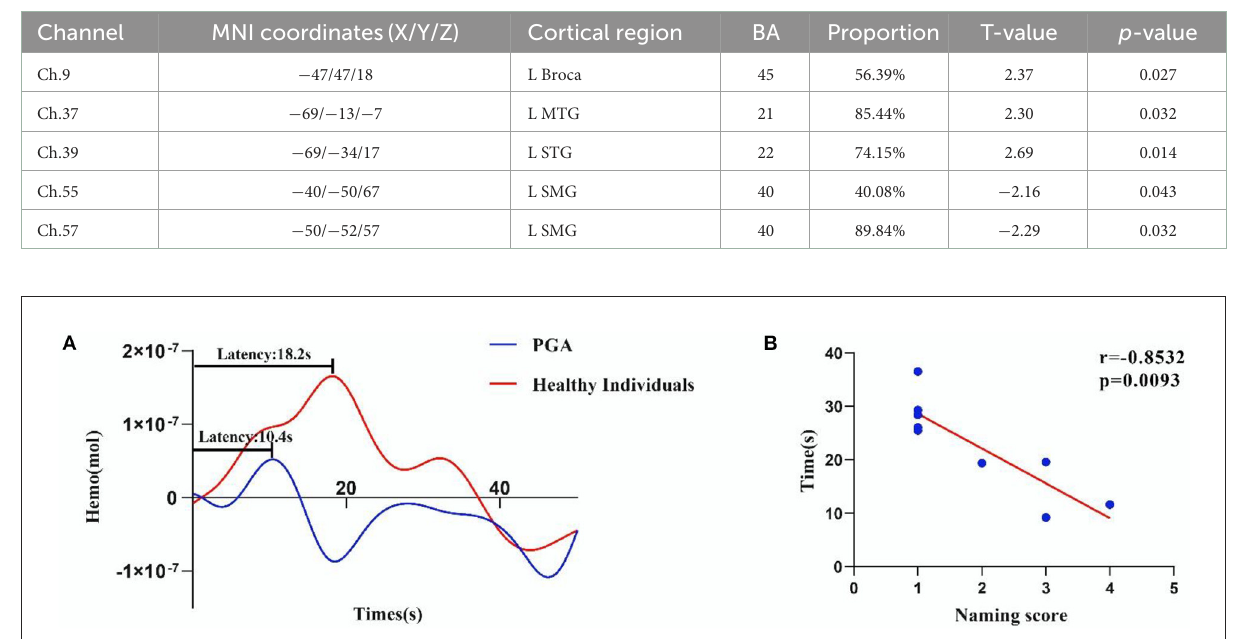
FIGURE4 Significant correlation between the naming score and latency of HbO concentration in the left SMG (r = − 0.8532, p = 0.0093). (A) The average HRF of the left SMG in patients with global aphasia and healthy individuals. (B) The accuracy of HbO concentration in the left SMG was negatively correlated with the naming score ( p < 0.01) (The latency of HbO concentration and the naming score in some patients are very similar (refer to Supplementary Table 5 for more detail).